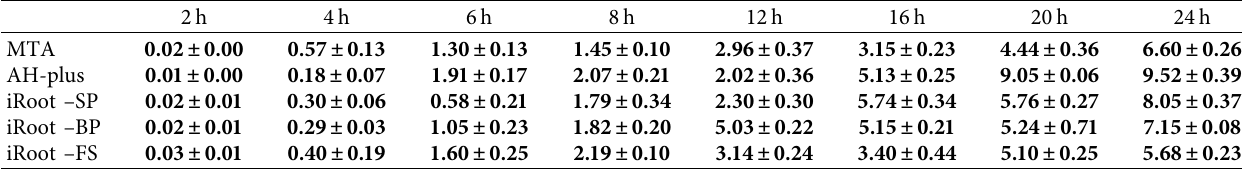
Table 9: Enterococcus faecalis group (plate colony counting).